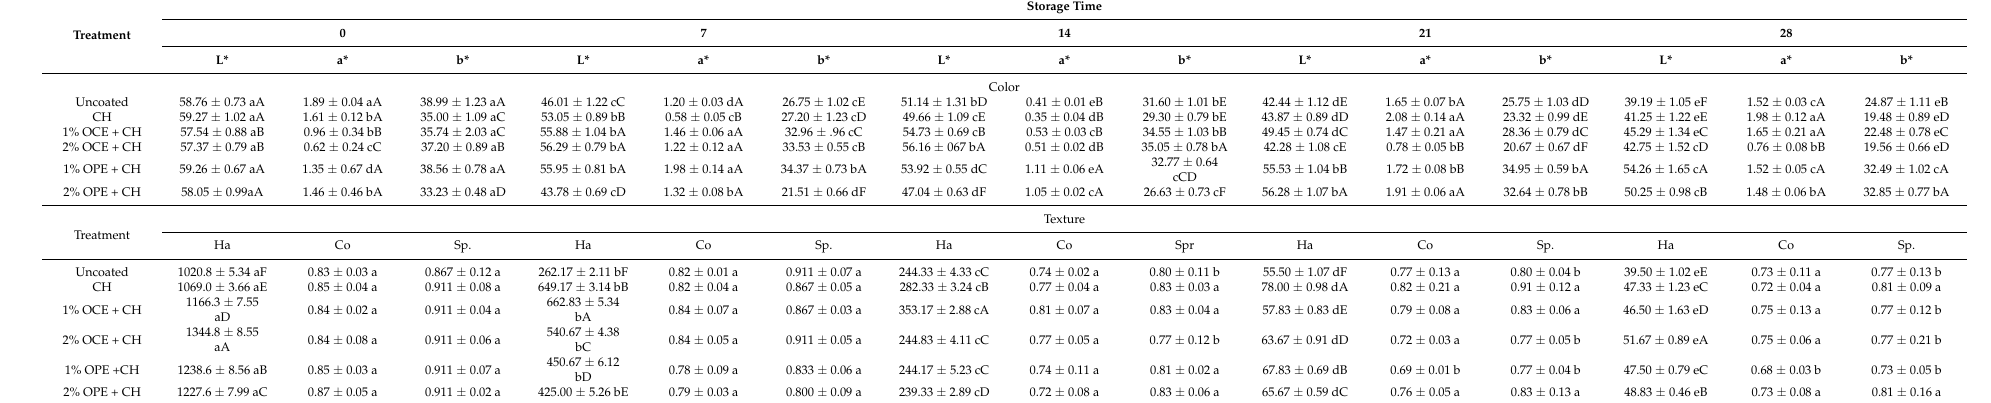
Table 3. Changes in color and texture of fresh Barhi dates coated with chitosan and/or olive cake or orange peel extracts during cold storage (4 ◦